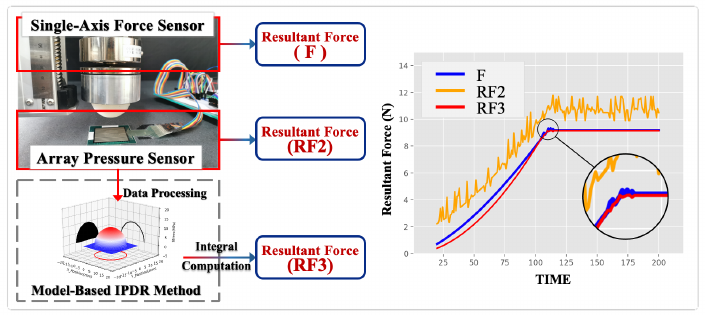
Figure 9. Comparison of resultant forces from data acquisition